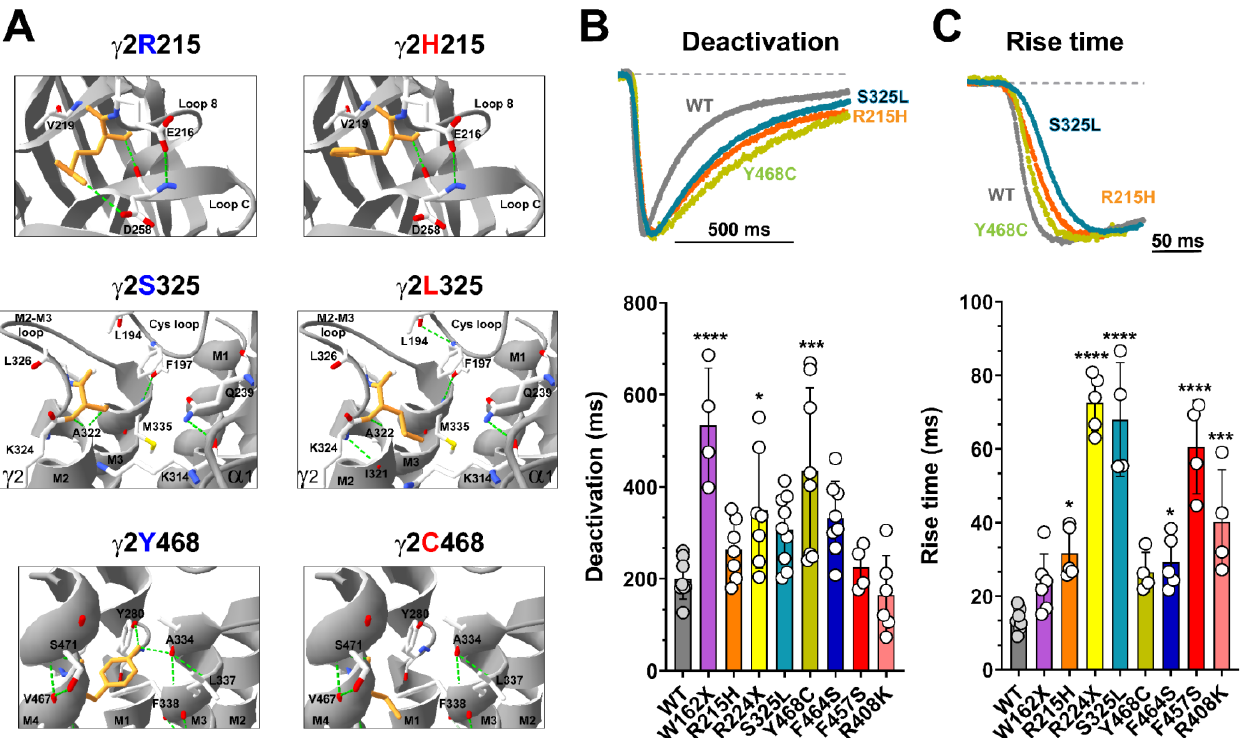
Figure 3. Mutant γ2 subunits altered the kinetic properties of GABA A receptors. ( A ) Close-up views of neighboring residues that were within a 6 Å radius at the site of the mutations corresponding to R215H, S325L, and Y468C in the γ2 subunit structures. The hydrogen bond network of the WT ( left panels ) and mutant structures are shown ( right panels ). Residues corresponding to the location of the substitution are colored orange, and the neighboring residues are colored as follows: carbon, white; oxygen, red; nitrogen, blue. Dashed lines indicate hydrogen bonds. ( B , C ) Superimposed representative current traces show deactivation (( B ), top panel ) and activation (( C ), top panel ) produced by 5 ms of GABA (1 mM) applications to WT (gray) and mutant receptors containing the γ2R215H (orange), γ2S325S (blue) , and γ2Y468C (green) subunits. Traces were normalized to WT currents for clarity. Dashed lines represent zero currents. Bar graphs show average deactivation time constant (( B ), bottom panel ), and rise time (( C ), bottom panel ) from cells co-expressing α1β3 subunits with mutant or WT γ2 subunits. Values are expressed as mean ± S.D (see Table 2). Data points (circles) represent the number of patched wells per experimental condition acquired in three independent experiments. One-way ANOVA with Dunnett’s post-test were used to determine significance. **** p < 0.0001, *** p < 0.001, and * p < 0.05, respectively, relative to WT condition.